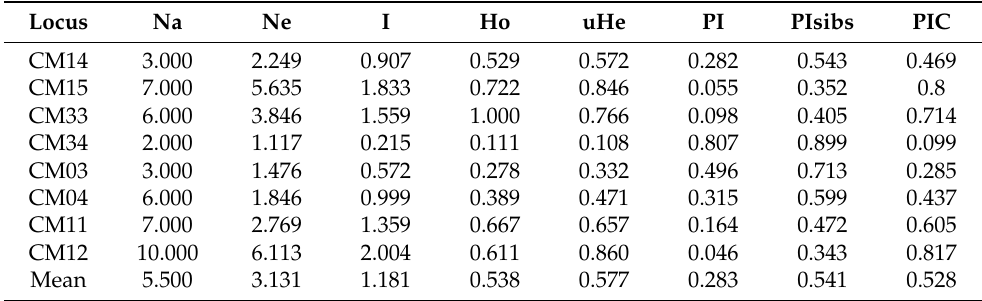
Table 8. Diversity statistics for the 18 native Greek rock samphire genotypes based on GenAlEx analysis for allelic